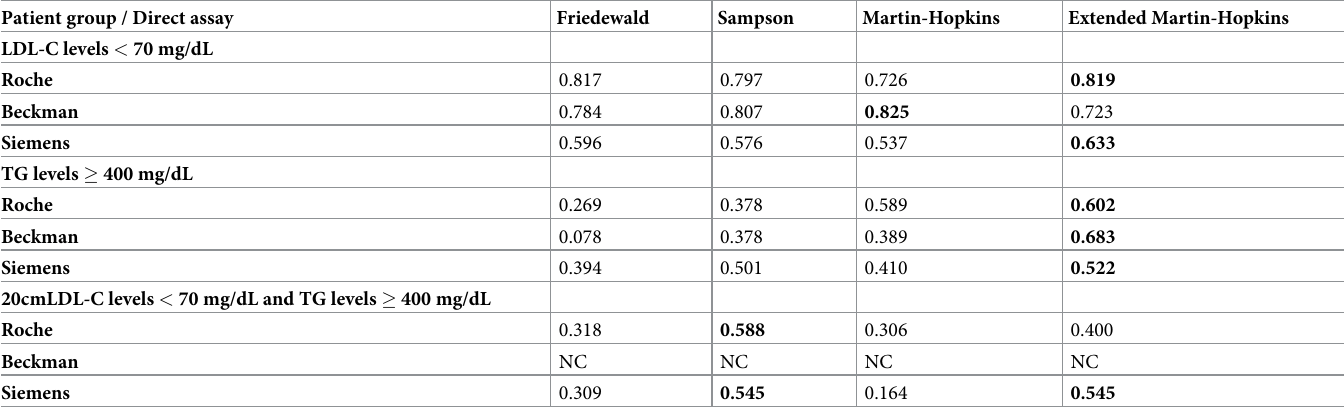
Table 3. The concordances of LDL-C estimation equations in patients with low LDL-C and/or higher TG levels. Patient group / Direct